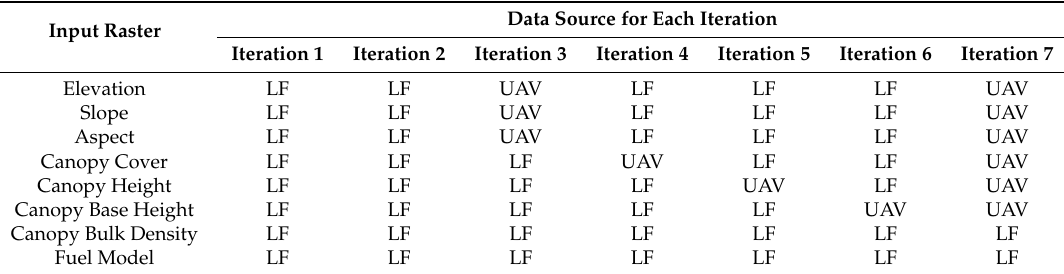
Table 2. Inputs rasters used in FlamMap to model crown fire behavior. The outputs from these iterations were then compared to assess the differences in fire behavior models with the UAV-derived inputs (UAV) versus LANDFIRE-based inputs (LF). All LANDFIRE data used were from the 2012 version. All raster input files were either resampled from LANDFIRE 30 m, or resampled from original UAV data resolution, to a matching resolution of 10 m. Iteration 1 modeled crown fire behavior using 30 m LANDFIRE data, Iteration 2 used LANDFIRE data resampled to 10 m. Iterations 3 to 6 tested UAV-derived rasters for topography, canopy cover, canopy height, and canopy base height, respectively. Iteration 7 used all available UAV-derived rasters.